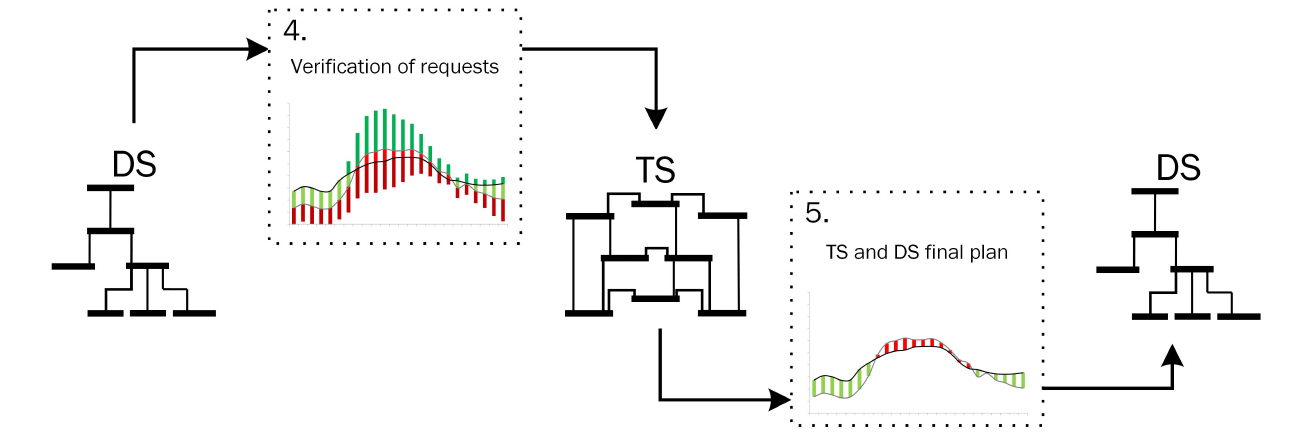
Figure 4. Scheme of the fourth and fifth stages in TSO–DSO coordination in